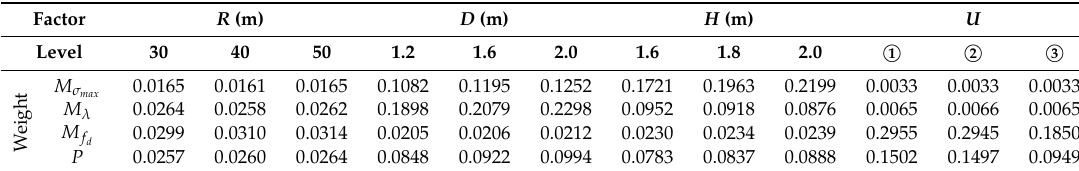
Table 10. Influence weight of